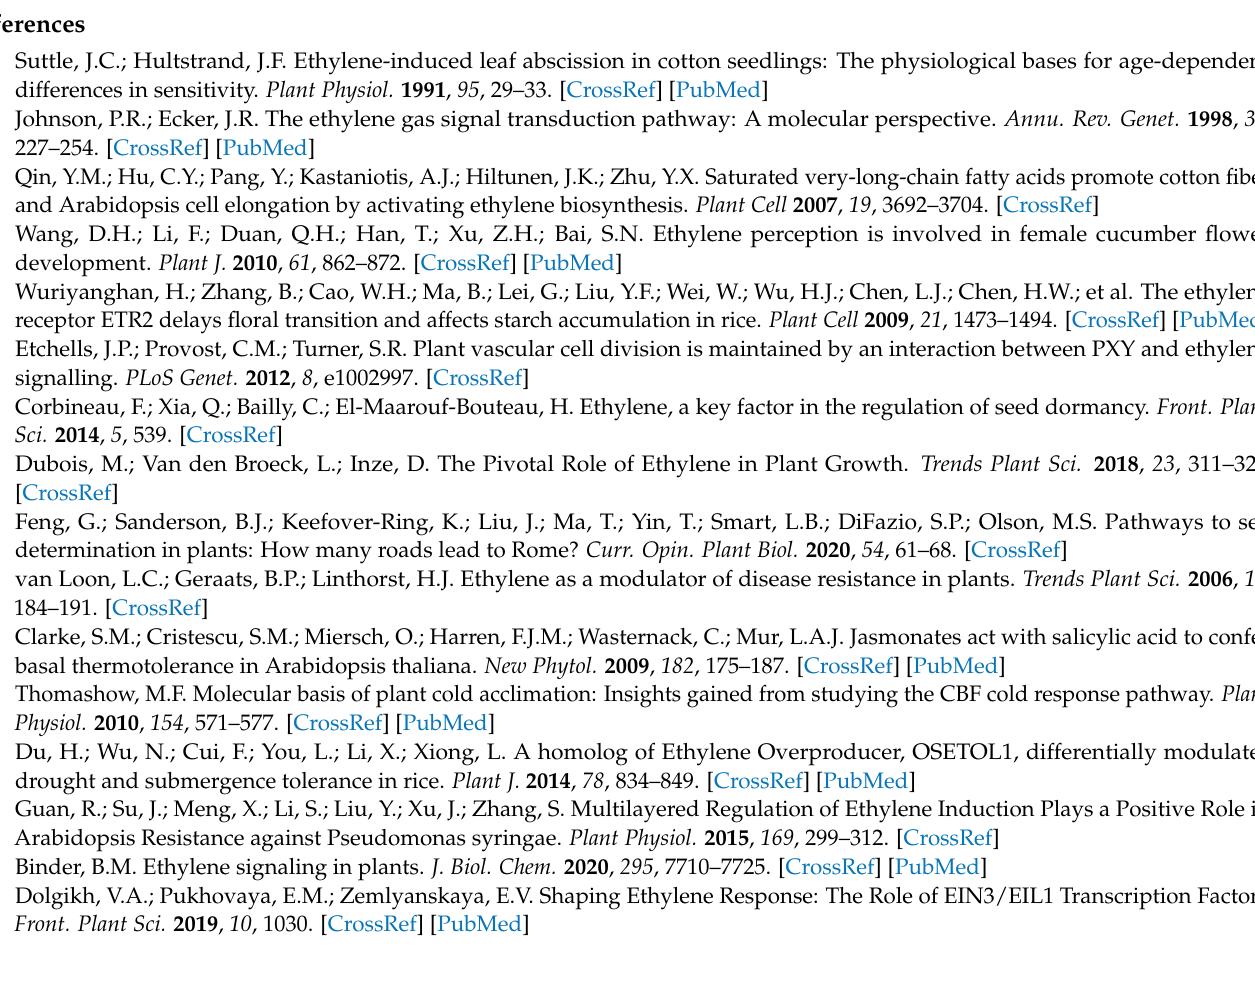
Figure S1: Phylogenetic tree of Populus × xiaohei and A. thaliana , Figure S2: The EIN3/EIL gene family promoter element prediction of P. trichocarpa